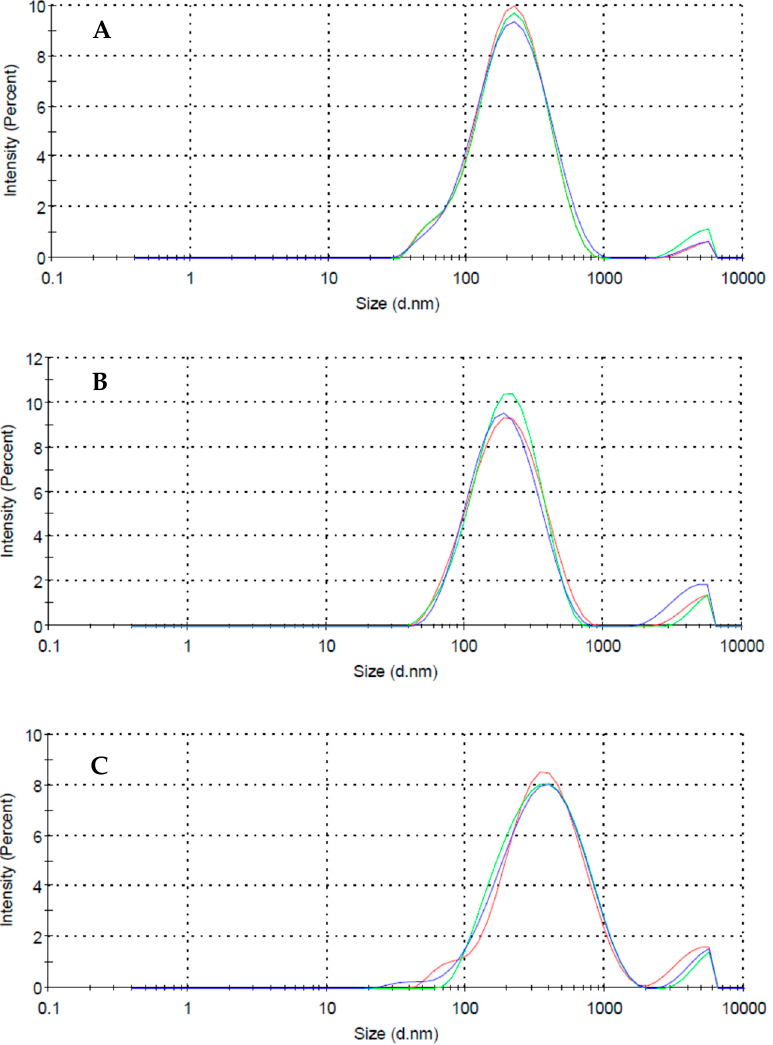
Figure 1. Intensity-weighted particle size distribution of the particles in a dispersion of 0.01% ( w / w ) of MWCNTs applying SDBS ( A ), Pluronic F-127 ( B ) and polyDADMAC MMW ( C ) as surfactant. Concentration of surfactant equal to 0.03% (w/w).